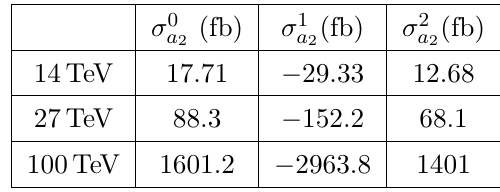
, σ 1 , and σ 2 in the expression (4.1) for pp → hhjj at three different a 2 a 2 a 2